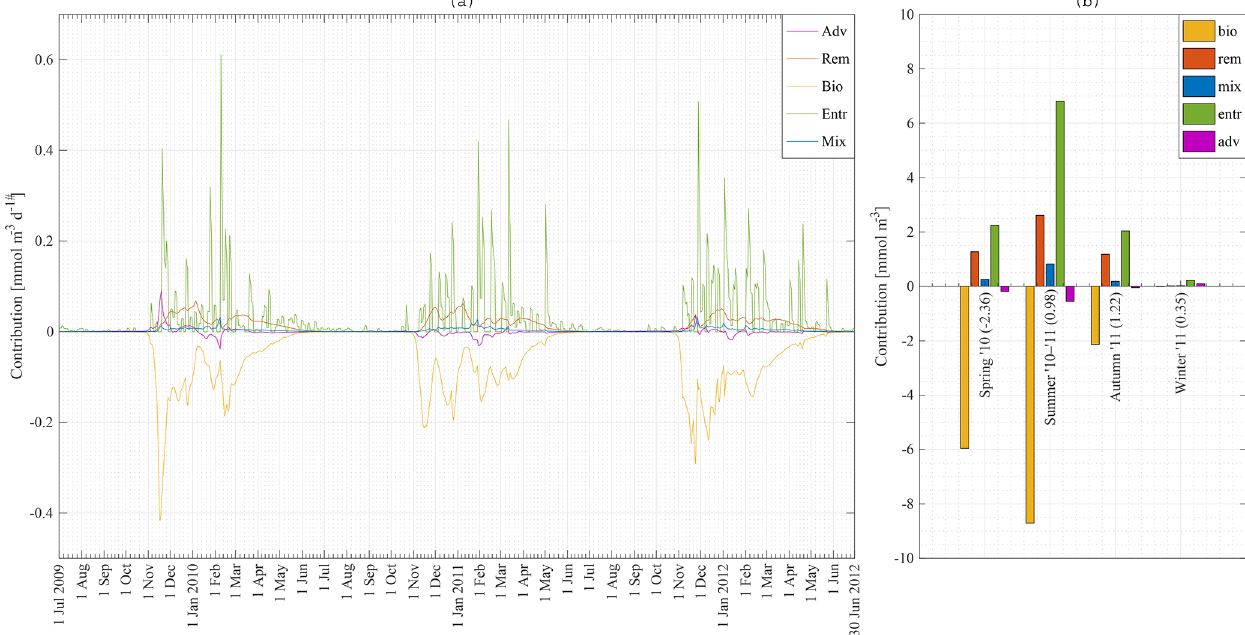
Figure 10. Model result: (a) absolute contribution of advection–upwelling, remineralisation, biology, diffusive mixing and entrainment to the nitrate concentration in the mixed layer at station 18 from 1 July 2009 to 30 June 2012. (b) Integration of (a) over the seasons: spring 2010, summer 2010–2011, and autumn and winter